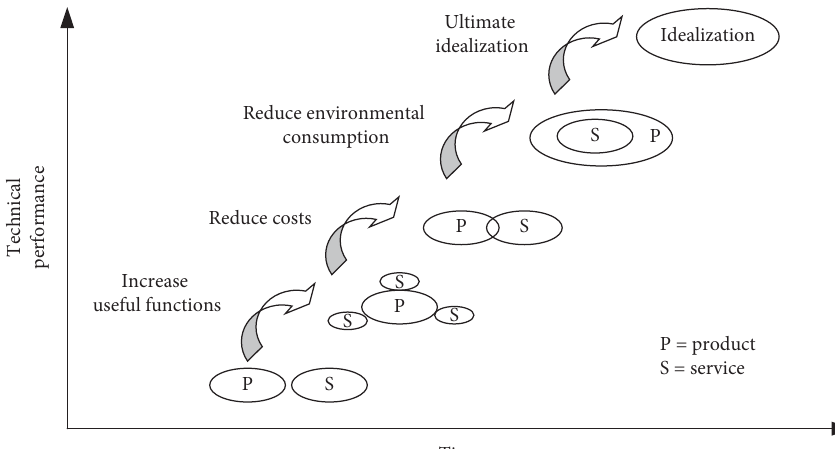
Figure 1: PSS evolution route.